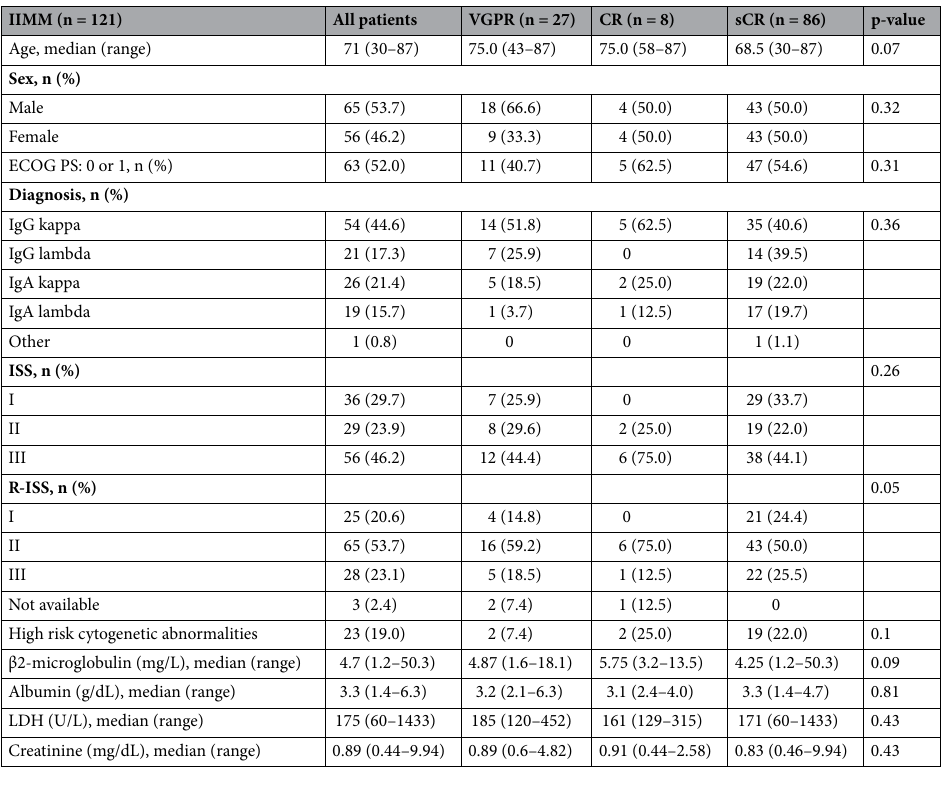
Table 2. Baseline characteristics of patients with IIMM. IIMM: intact immunoglobulin multiple myeloma; ECOG: Eastern Cooperative Oncology Group; PS: performance status; ISS: international staging system; R-ISS: revised international staging system.